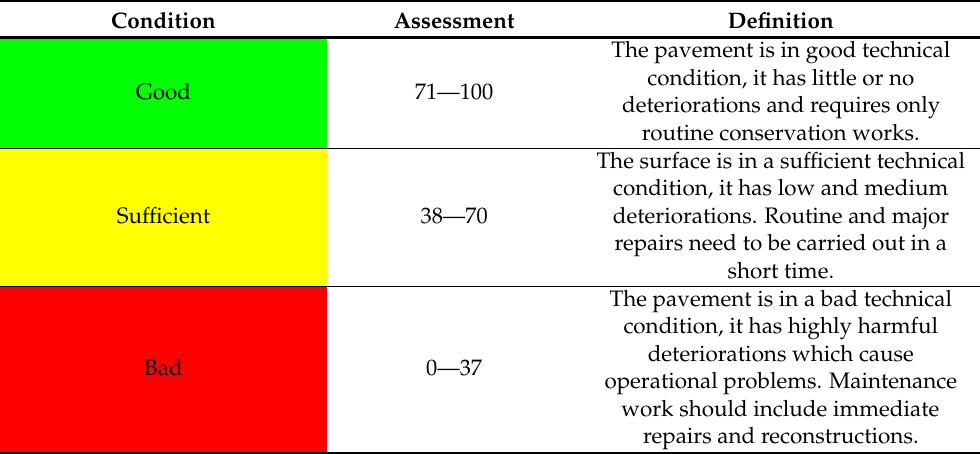
Figure 11. Criteria for assessing the technical condition of the AFE natural pavement using the APCI method. Table 5. Criteria for assessing the technical condition of the AFE natural pavement.